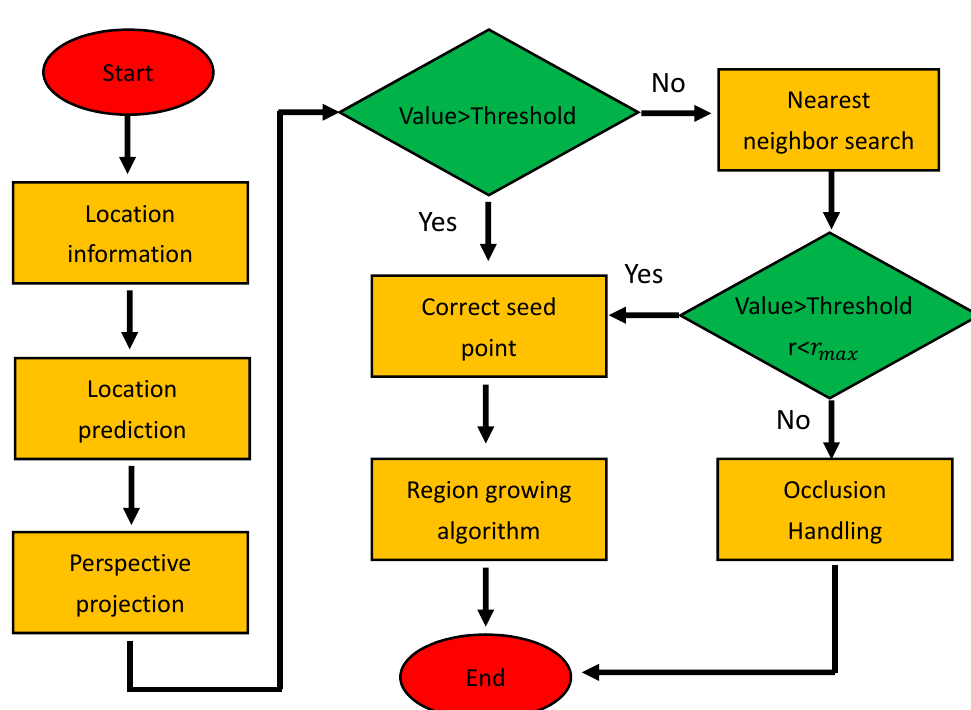
Figure 7. The flow diagram of fast nearest neighbor feature point extraction algorithm (FNNF). Specific steps of the algorithm are as follows.